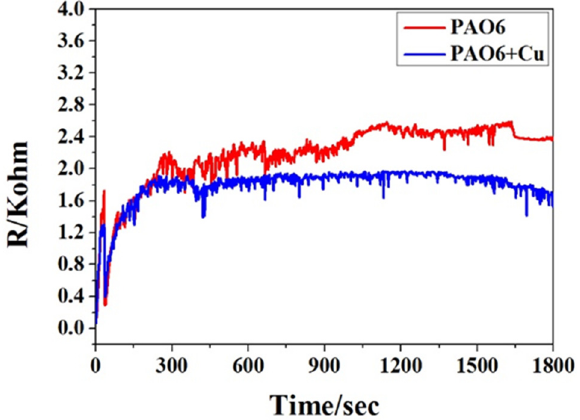
Figure 9. Variation curve of surface contact resistance of steel/DLC friction pair lubrication with PAO6 and PAO6 + 0.1 wt.% Cu.